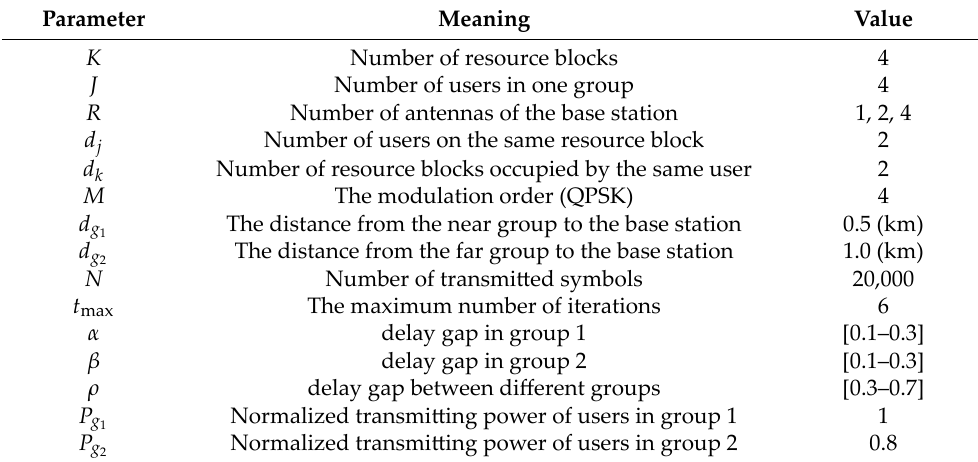
Table 2. Parameters and values in proposed algorithms. Parameter Meaning Value K Number of resource blocks J Number of users in one group 4 R Number of antennas of the base station 1, 2, 4 d j Number of users on the same resource block 2 d k Number of resource blocks occupied by the same user 2 M The modulation order (QPSK) 4 d g The distance from the near group to the base station 0.5 (km) 1 The distance from the far group to the base